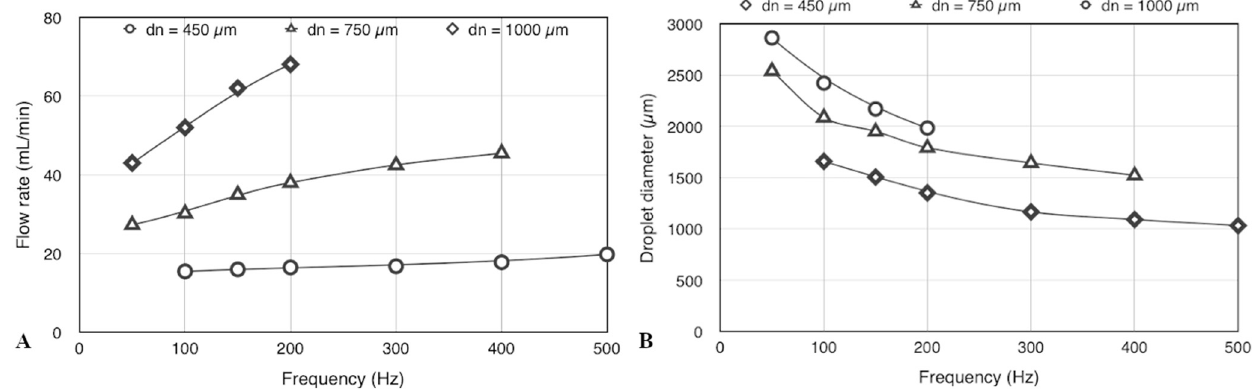
Figure 6. ( A ) Selected flow rate in function of the frequency to maintain optimum breakage. ( B ) Effect of the frequency on the droplet diameter for different nozzle sizes.